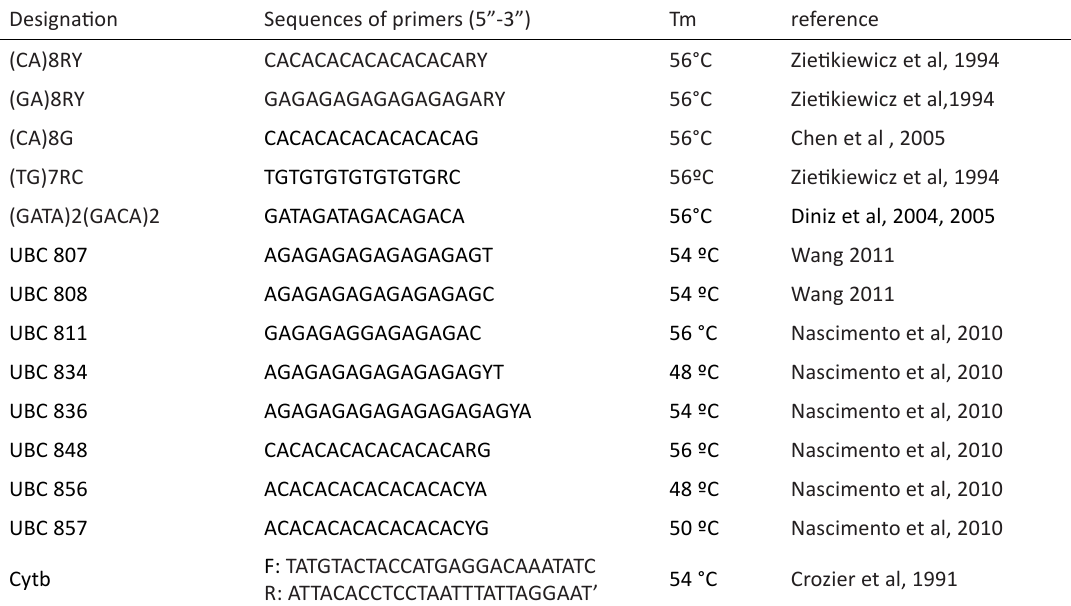
Table 2 - Primers utilized in this study for the analysis of genetic